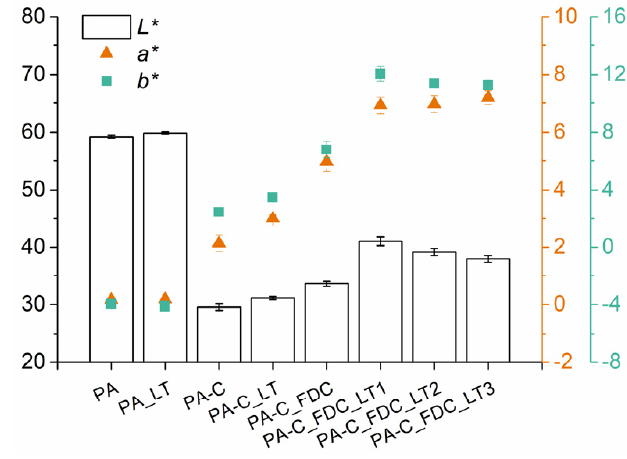
Figure 5. L*a*b* values of samples determined by colorimetry .